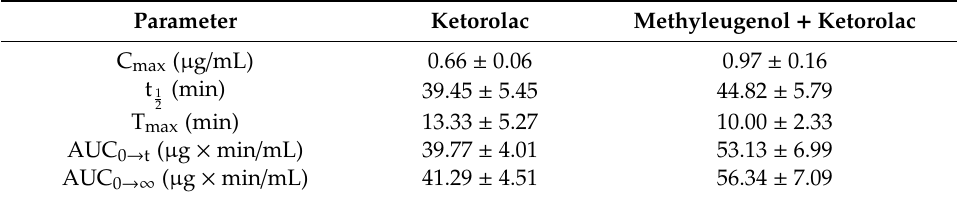
Table 4. Parameters of the pharmacokinetics ascertained after oral administration of the vehicle plus ketorolac (1.64 mg / kg) or methyleugenol plus ketorolac (1.9 and 1.64 mg / kg, respectively) to rats. Data represent the mean ± SEM ( n =